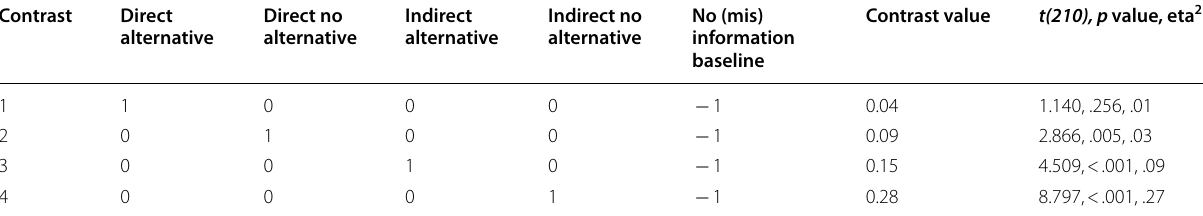
One-way ANOVA , F (4, 210) 23.744, p < .001 = Table 5 Contrast Analyses to Test for Correction Effectiveness in Experiment 1B. Contrast Values Refer to Difference in Mean (Mis) information Score Between an Experimental Condition and the No Correction Baseline Condition